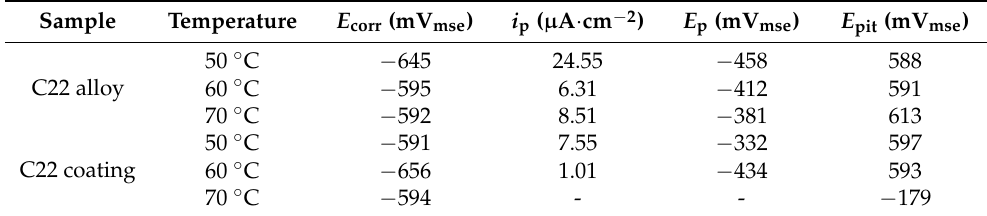
Figure 2. Potentiodynamic polarization curves of the C22 alloy ( a ), C22 coating ( b ) in 50 wt.% H 2 SO 4 at 50–70 ◦ C. Table 2. Electrochemical parameters of the C22 alloy and C22 coating at different